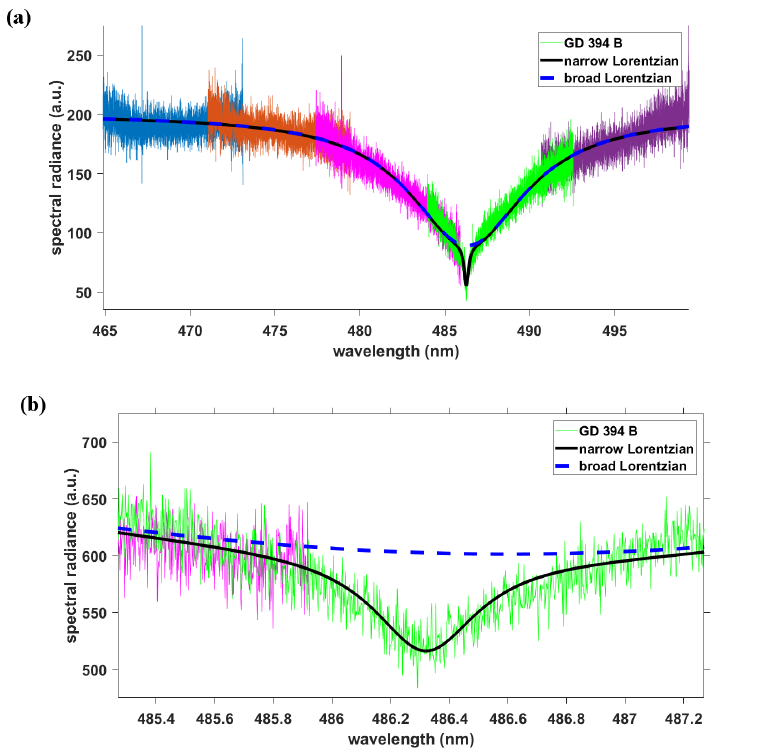
Figure 15. White dwarf GD 394 B, H β combined absorption profiles, recorded with the HIRES echelle spectrometer, KOA-ID: HI.20151115.17054 [3]: ( a ) fitting with two Lorentzians; and ( b ) expanded